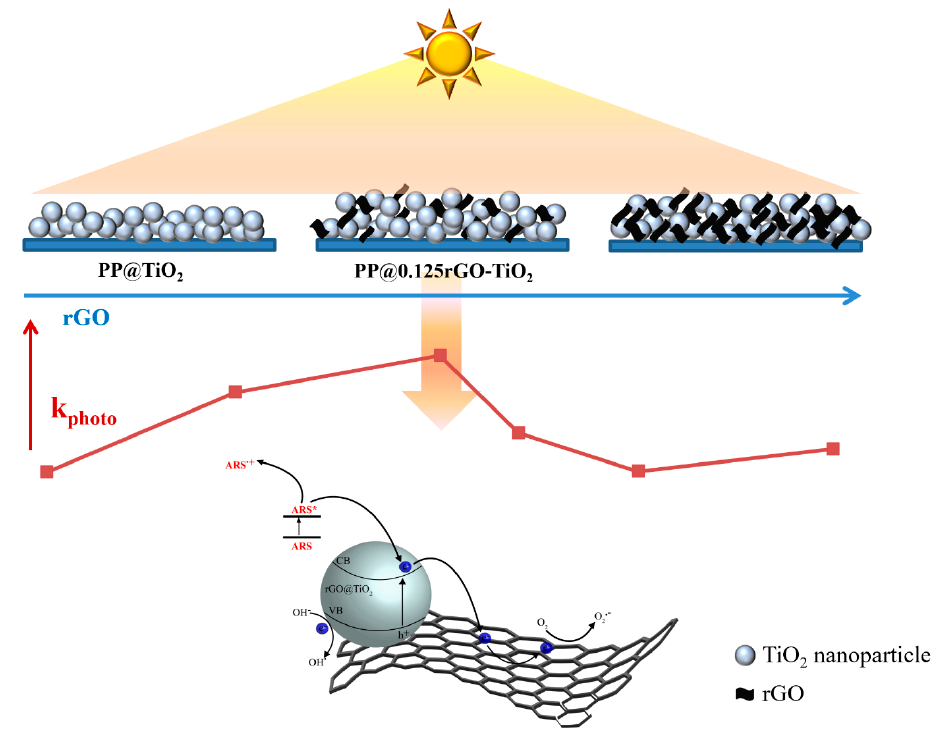
Figure 11. Schematic representation of PP@rGO-TiO 2 photocatalysts: characteristics and properties. Author Contributions: M.Z., R.G., and E.R. proposed and designed the experiments; E.R. and C.A.D. performed the experiments; M.M., R.G. and M.Z. analyzed the data; R.G., S.F. and A.D.C. contributed to reagents, materials, analysis tools; M.Z., R.G. and E.R. wrote the paper. All the authors participated in